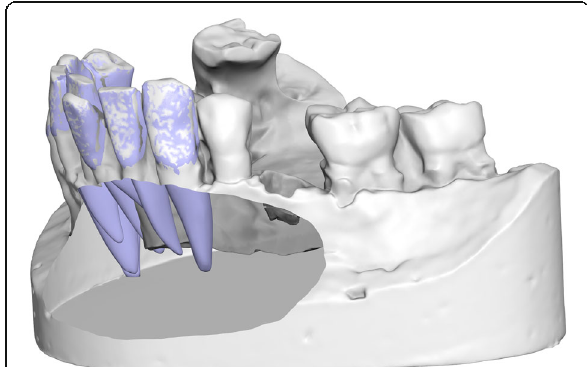
Fig. 3 Superimposition of the teeth and roots, as estimated by the software, on the digital cast. Only the crowns were used for the alignment. The cast has been cut to reveal the estimated